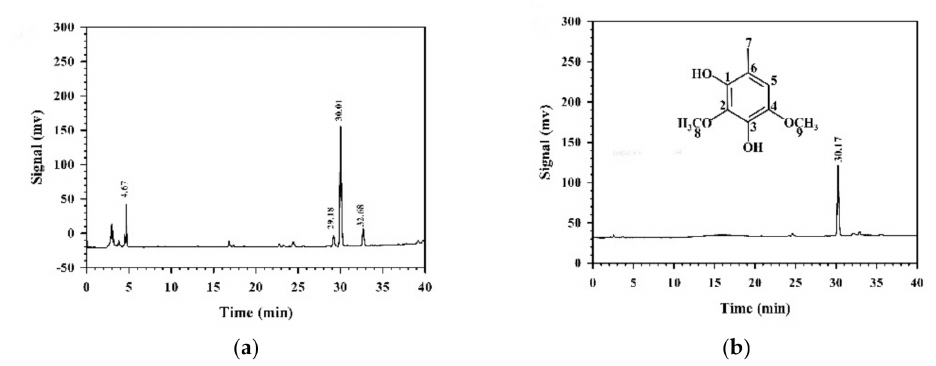
Figure 4. HPLC fingerprints of MEAC-KLEE ( a ) and its purified fraction ( b ) on an SPE C18 column. The chemical structure of the main peak was identified as DMMB (MW 170) based on 1 H-NMR, 13 C-NMR, and mass spectra.